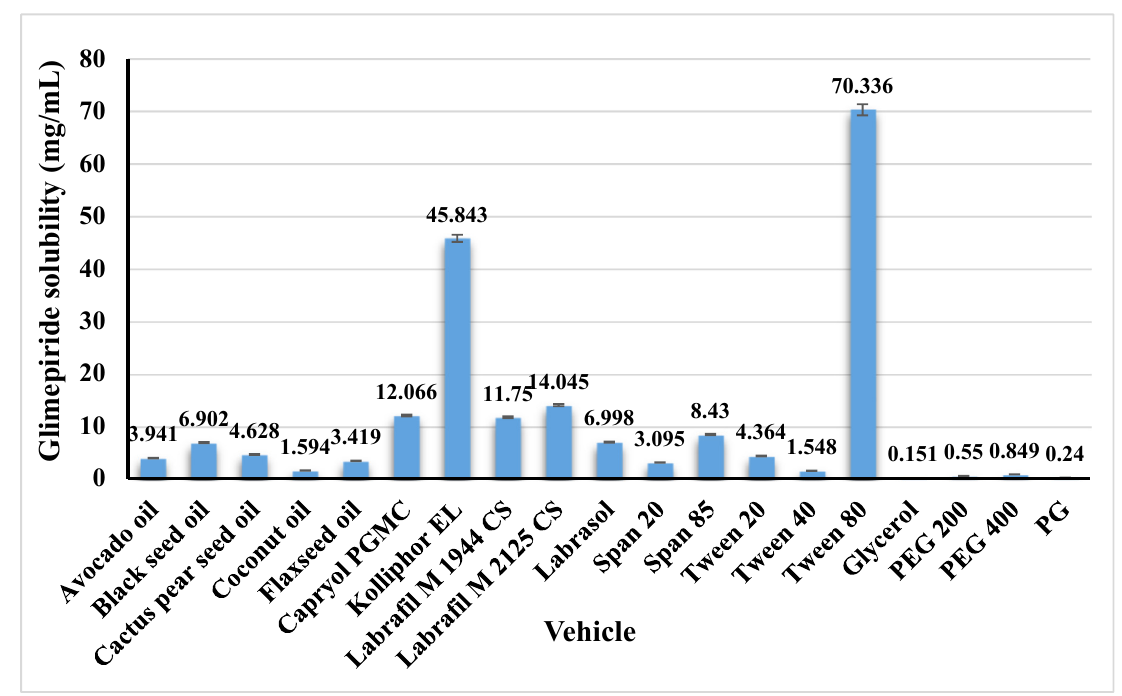
Figure 1. Solubility of glimepiride in the studied vehicles. Data are presented as mean ± SD ( n = 3).